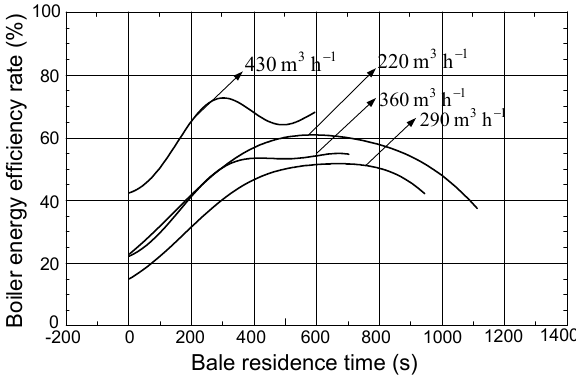
Figure 11. Correlation between boiler energy efficiency rate and bale residence time, model (7), recirculation 33%.